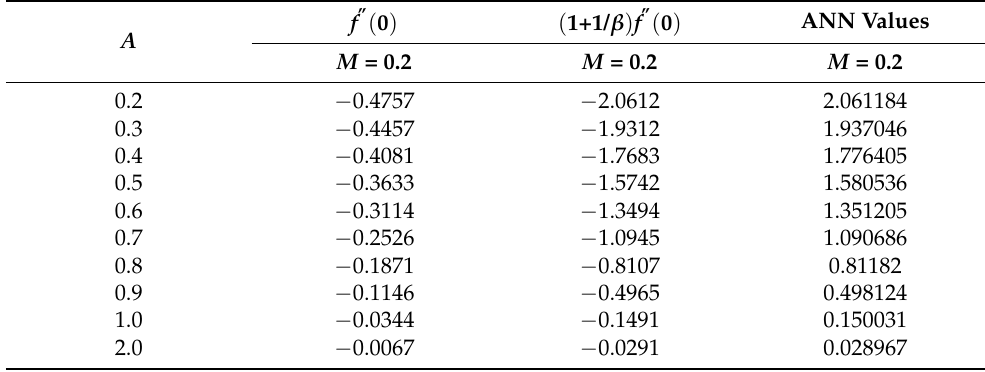
Table 4. Impact of the velocities ratio parameter on the SFC for the nonmagnetic flow field.